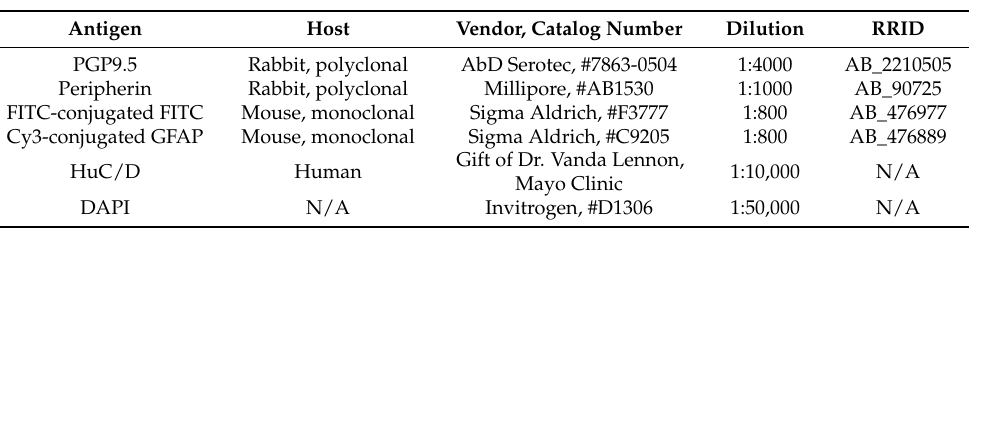
Table 3. Primary antibodies used in